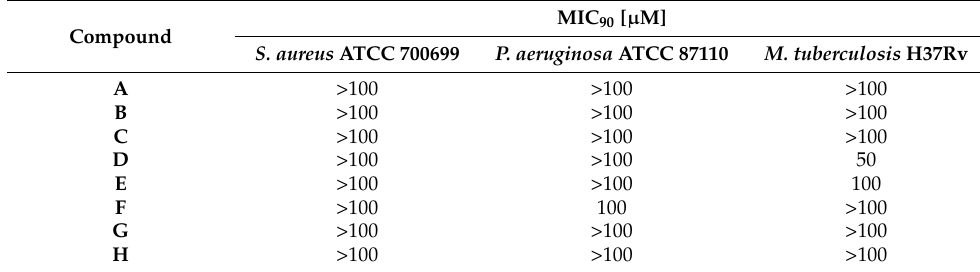
Table 4. MIC 90 against S. aureus ATCC 700699, P. aeruginosa ATCC 87110, and M. tuberculosis H37Rv. All concentrations are shown in µ M. Concentration >100 µ M indicates no activity in the experimental setup. All experiments were conducted in